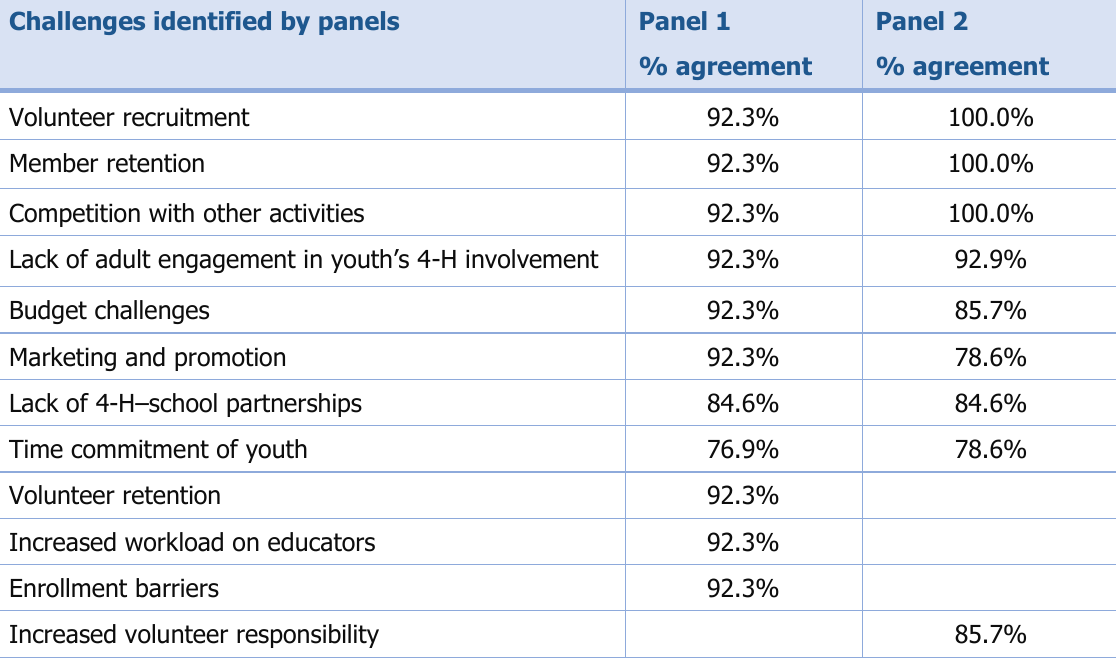
Table 5. Comparison of the Challenge Statements Identified by Both Panels That Reached Consensus After Three Rounds Challenges identified by